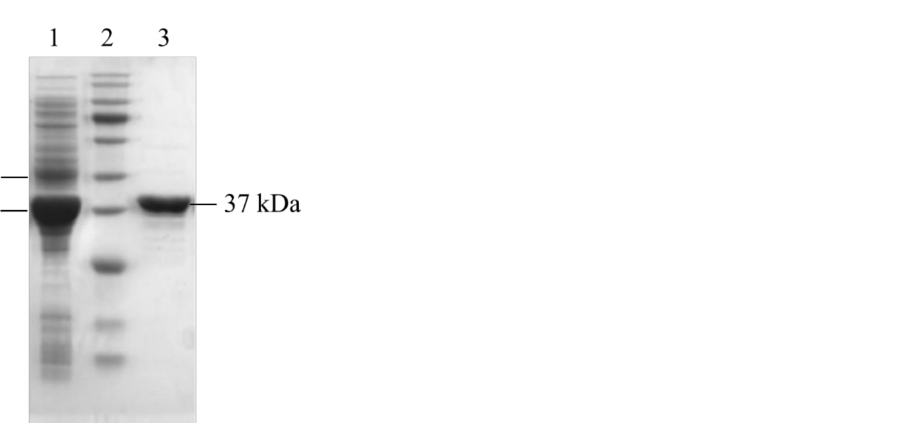
Figure 1. SDS-PAGE profiling of DhaA. Lane 1: crude lysate; Lane 2: marker; Lane 3: purified DhaA (37 kDa).